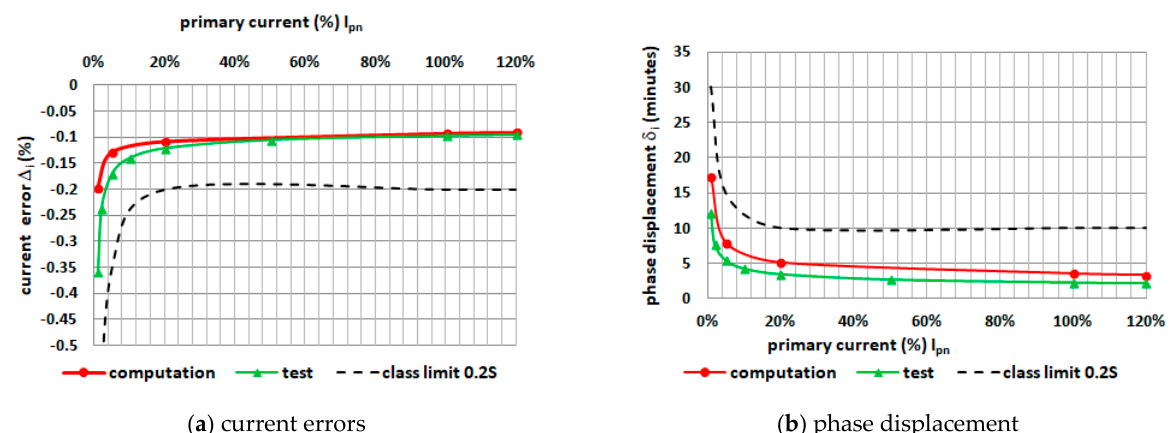
Figure 6. Comparison of the characteristics of the current error ( a ) and phase displacement ( b ) from the calculations and tests for 600 A/5 A current transformers with a toroidal core at a power load of S n = 2.5 VA. cos φ = 0.8 (I pn = 600 A).